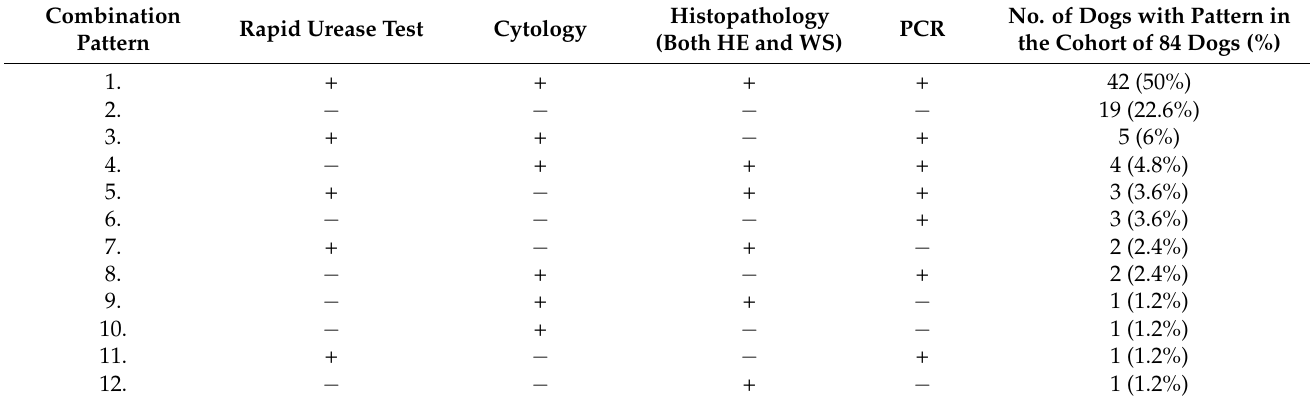
Table 3. Concordance of test results for Helicobacter infection in 84 dogs with chronic gastrointesti- nal signs.